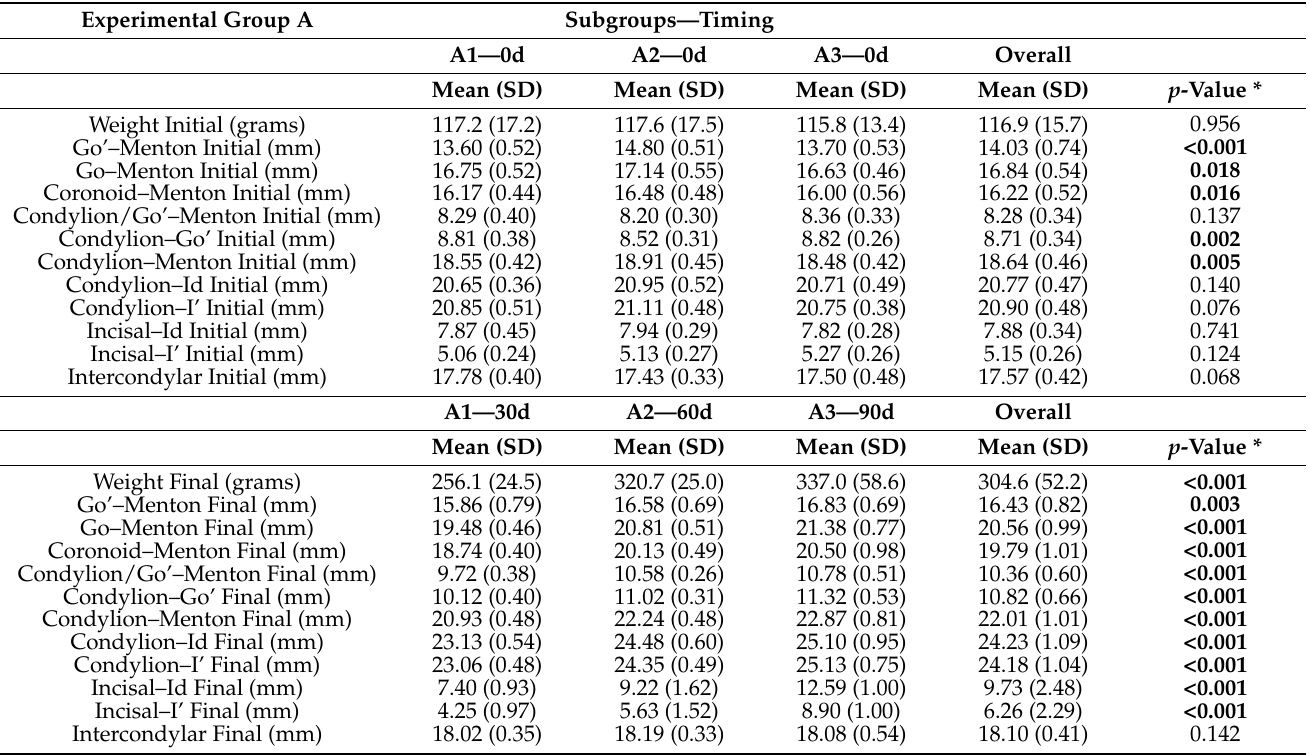
Table 2. Descriptive statistics (mean and standard deviation) for each measurement by subgroups and overall, for experimental group A.